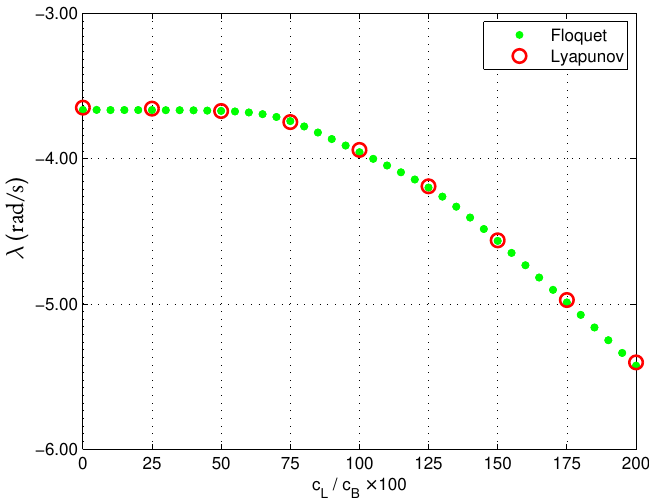
Figure 5. Characteristic exponents estimated by Lyapunov theory (LCEs) and Floquet multipliers, corresponding to the lightly damped blade lag mode, isolated and zoomed from Figure 4